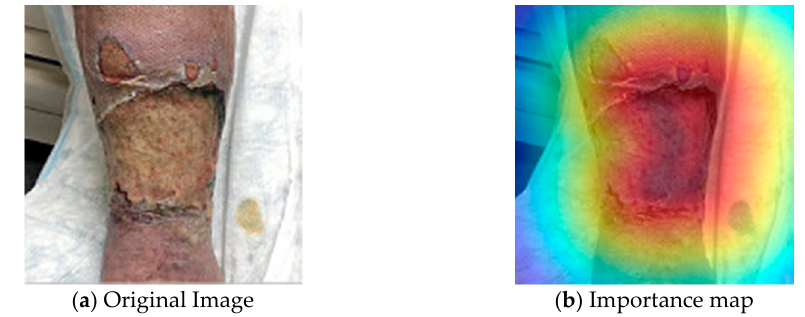
Figure 6. The probabilities of wound types: Lymphovascular: 100%, diabetic: 0%, pressure Injury: 0%, surgical: 0% (Lymphovascular).